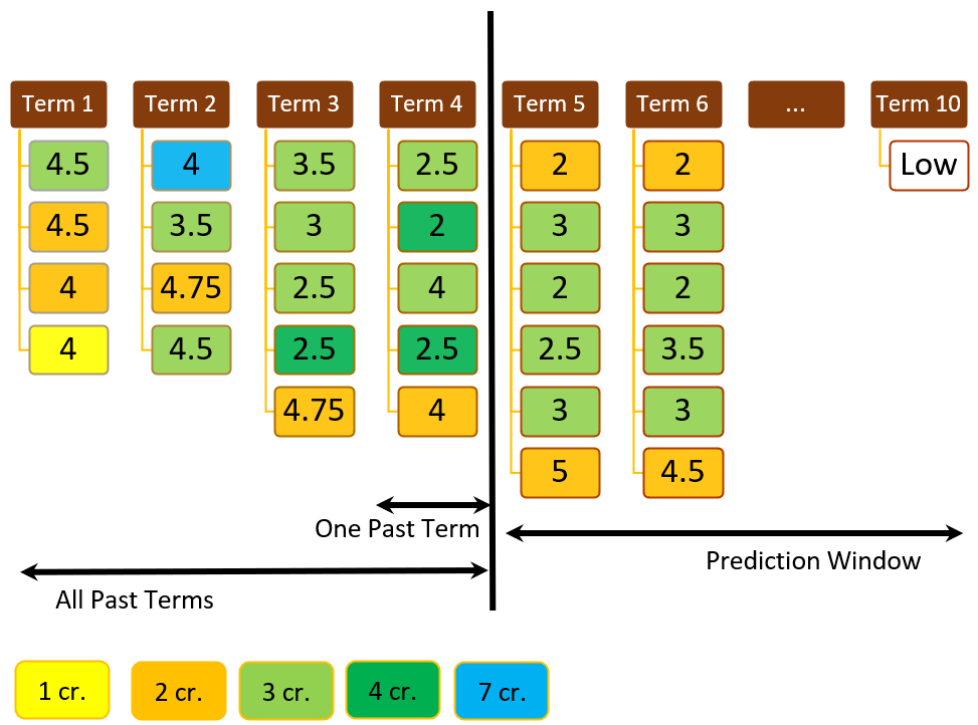
Figure 3. Sampe student transcript data (color code is, yellow: 1, orange: 2, light green: 3, dark green: 4, blue: 7 credits each).